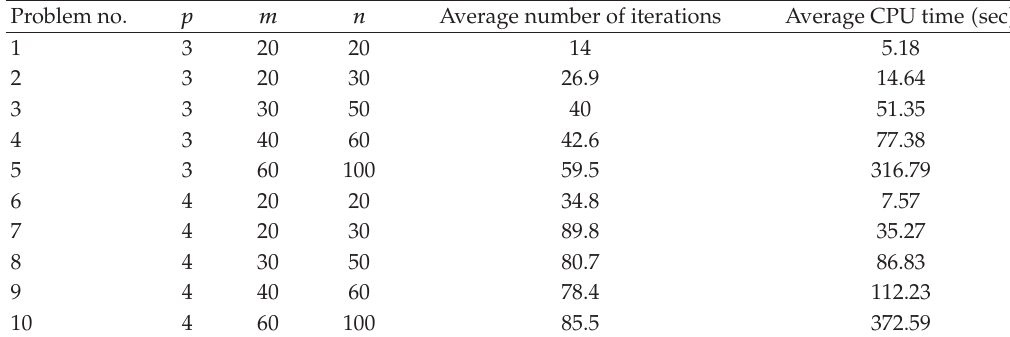
Table 2: Computational results on the problem of Type